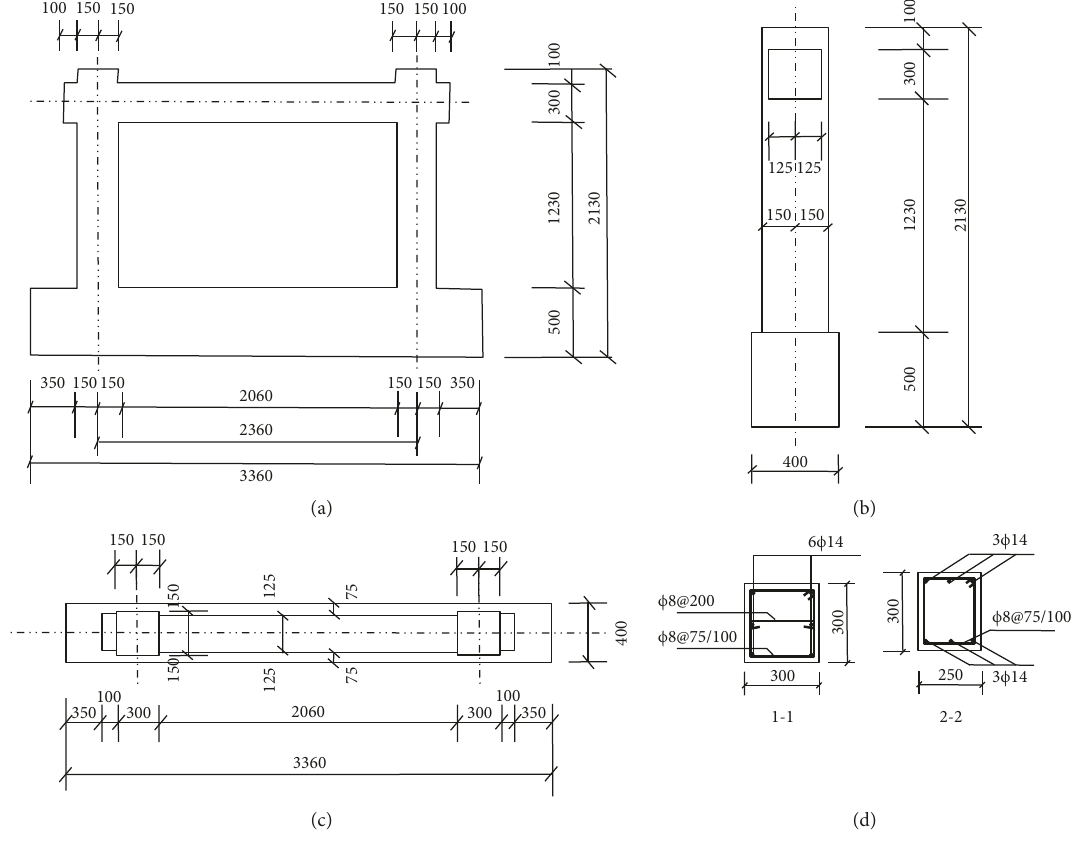
Figure 13: Dimensions and reinforcements of RC frame.